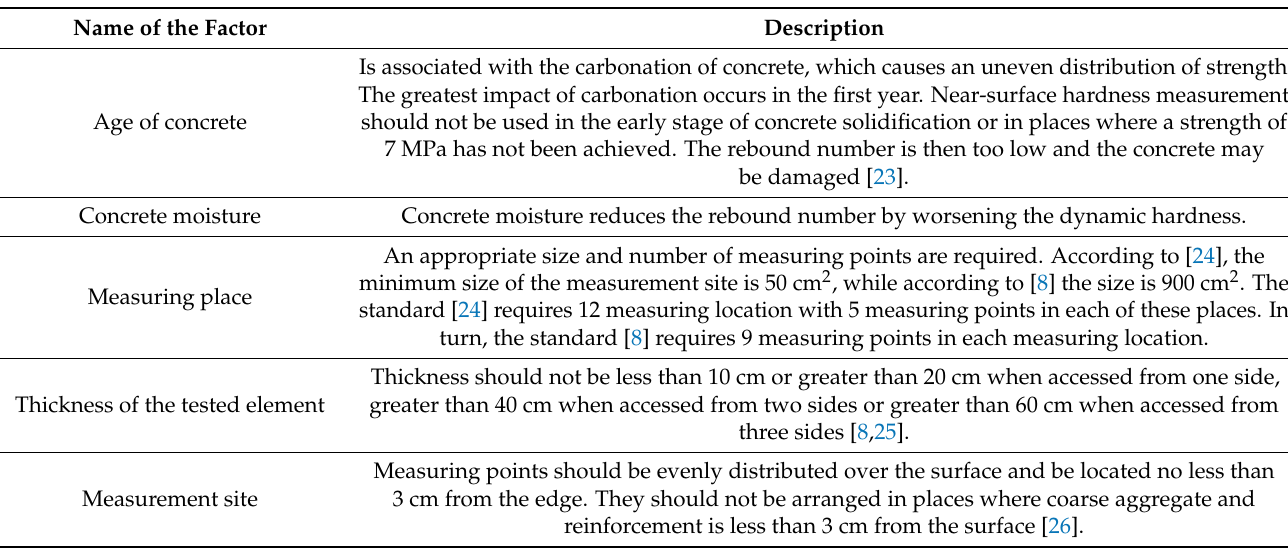
Table 1. Known factors influencing near-surface hardness